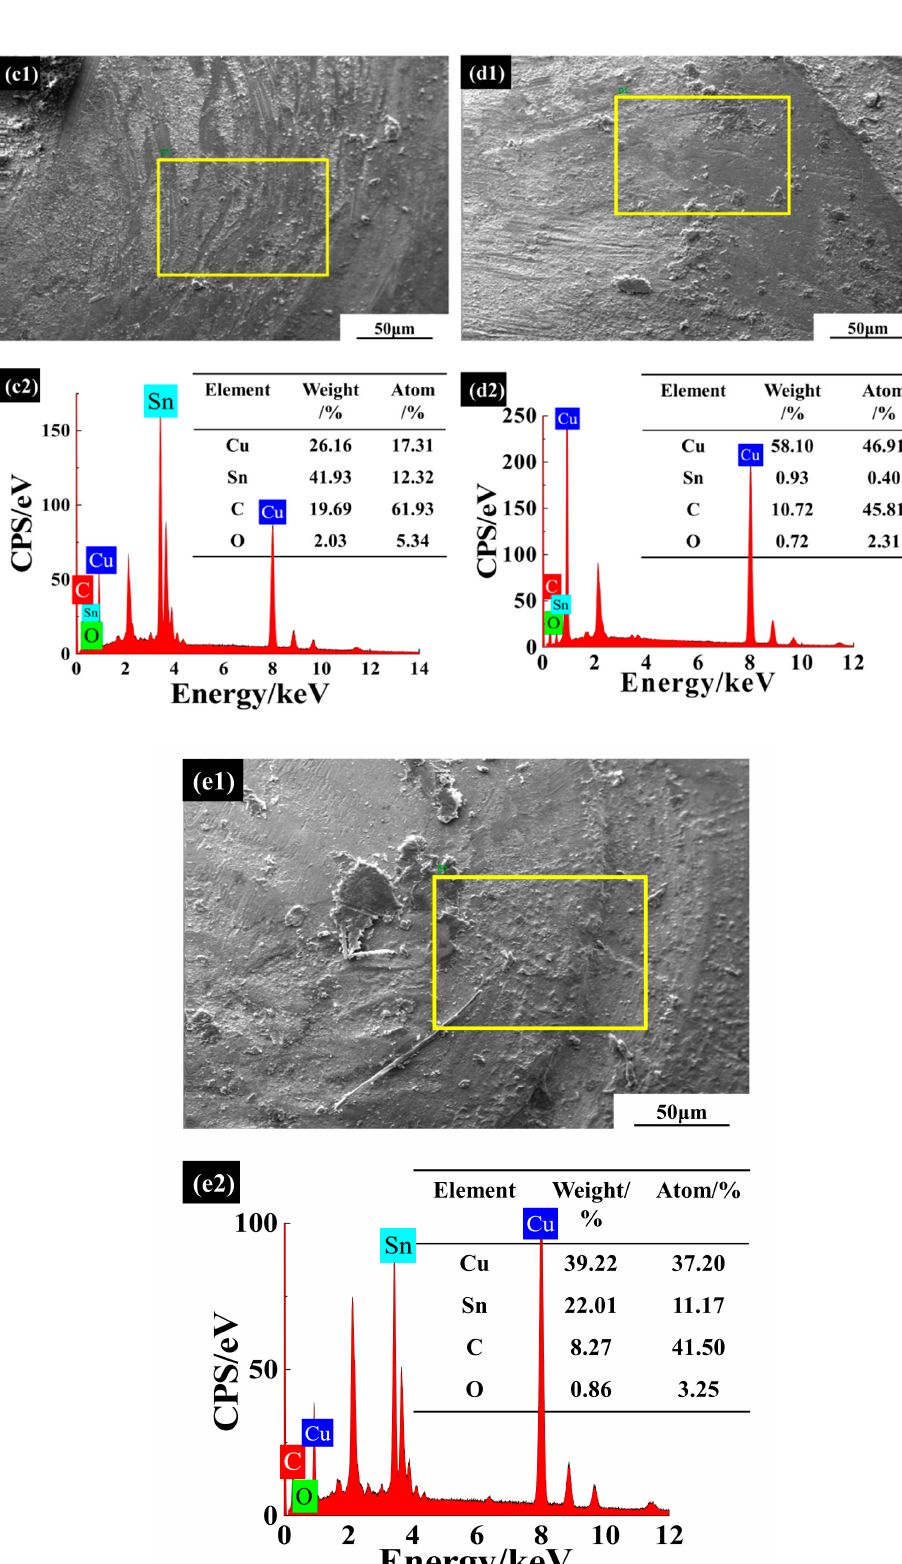
Figure 5. Micro-morphology of the contact surface in air ( a1 )–( e1 ) and corresponding EDS energy spectrum of magnified yellow areas ( a2 )–( e2 ) at the sliding speeds of ( a1 ) and ( a2 ) 24 mm/s, ( b1 ) and ( b2 ) 50 mm/s, ( c1 ) and ( c2 ) 76 mm/s, ( d1 ) and ( d2 ) 95 mm/s and ( e1 ) and ( e2 ) 119 mm/s. (The part circled by the yellow box is the analysis area of EDS energy spectrum).